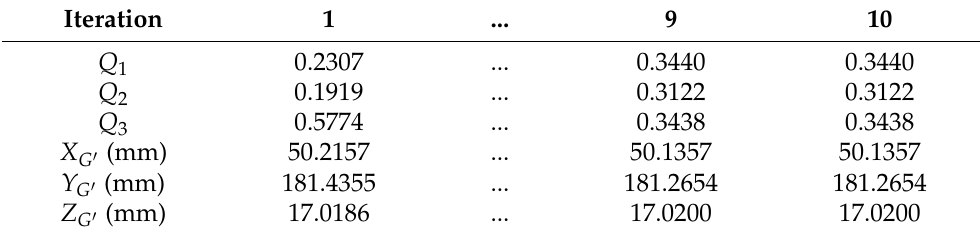
Table 11. The iteration of first experiment.